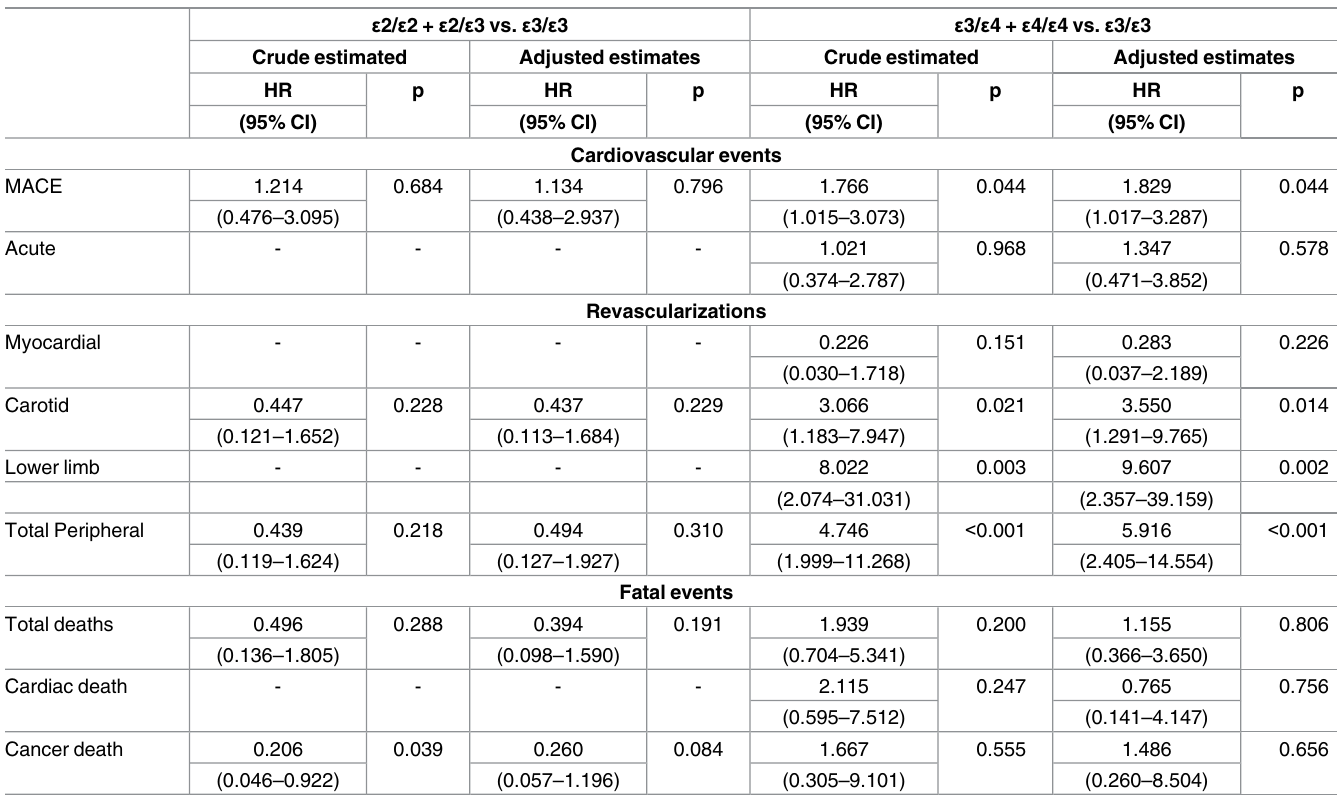
Table 4. Hazard ratios for incident cardiovascular